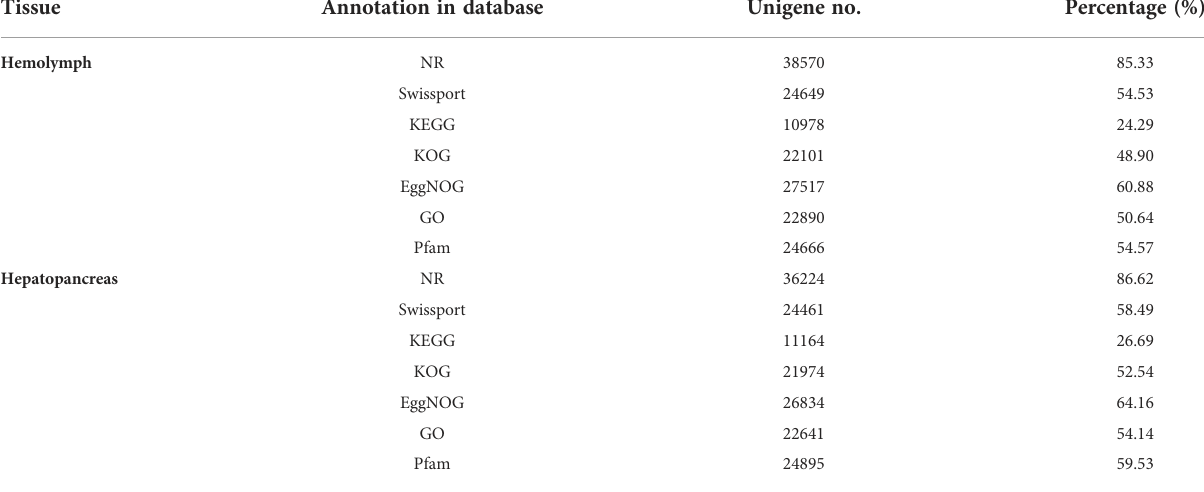
TABLE 3 Summary of functional annotation of P. trituberculatus transcriptome. Tissue